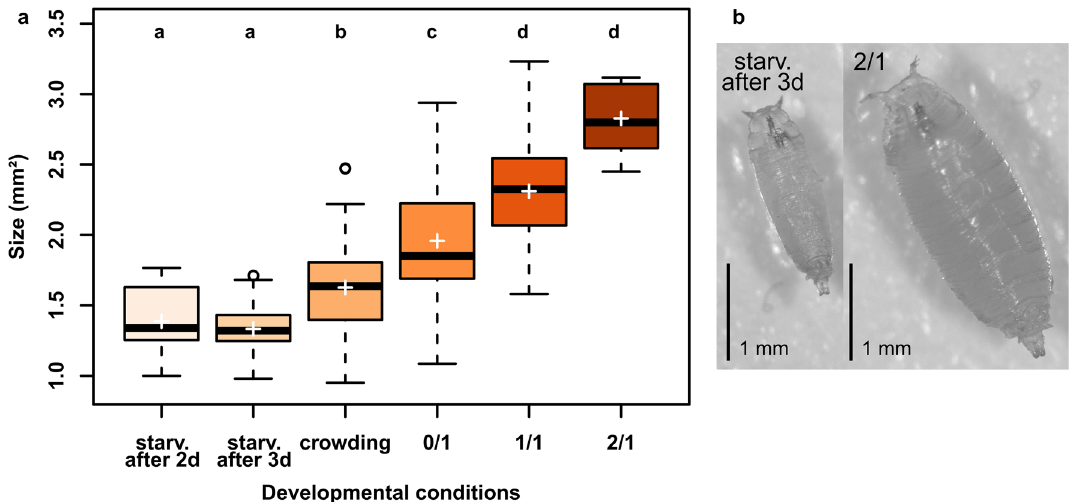
Figure 1. Pupal size (in mm 2 ) for laboratory-reared pupae that developed on different diets ( a) . Picture of a pupa from the high-sugar (2/1) and starvation after 3 days of feeding treatments ( b ). Different letters denote significant differences based on estimated marginal mean comparisons (p value < 0.05). Boxes represent the 25–75 percentile range, horizontal lines display the median and crosses represent the mean. Diets: 1/1: standard medium; 2/1: twice the amount of sugar; 0/1: no sugar; crowding: 300 eggs in 1 ml of standard medium; starv.: starvation after 2 (2d) or 3 days (3d) of feeding on standard medium. Sample sizes are presented in Table